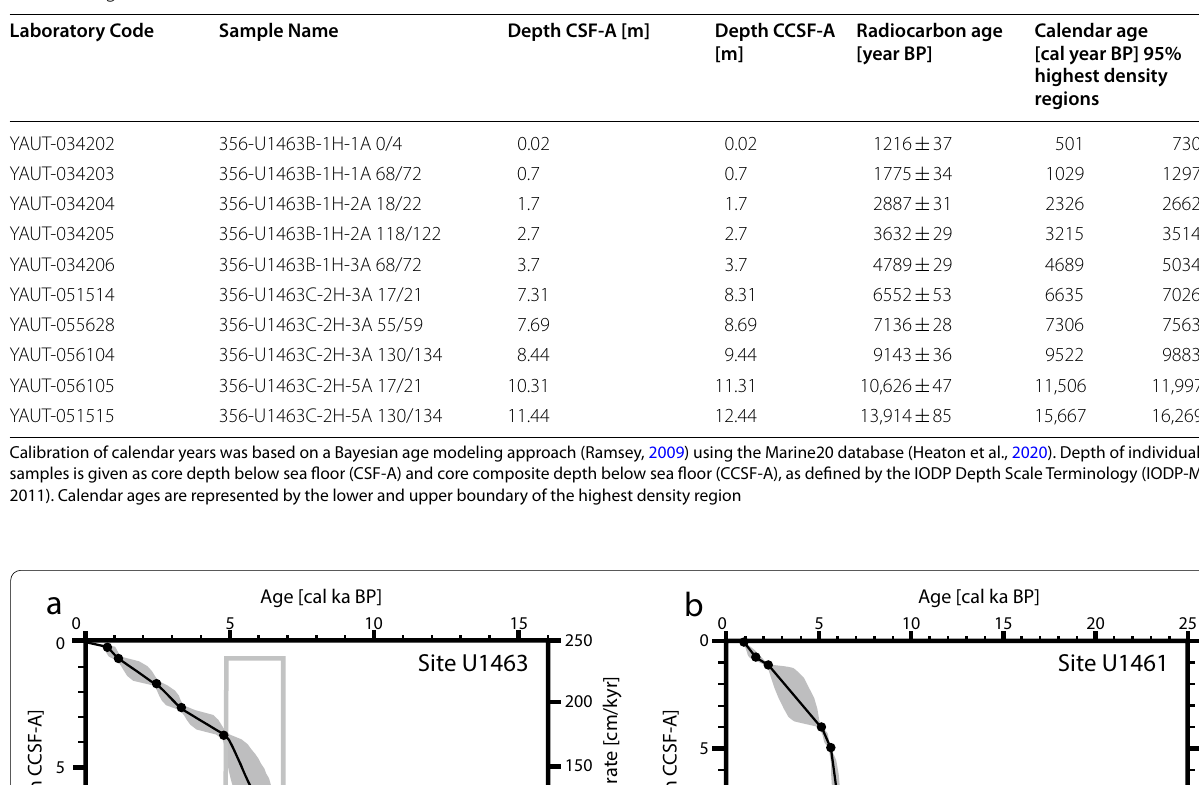
Table 1 Age results of Site U1463